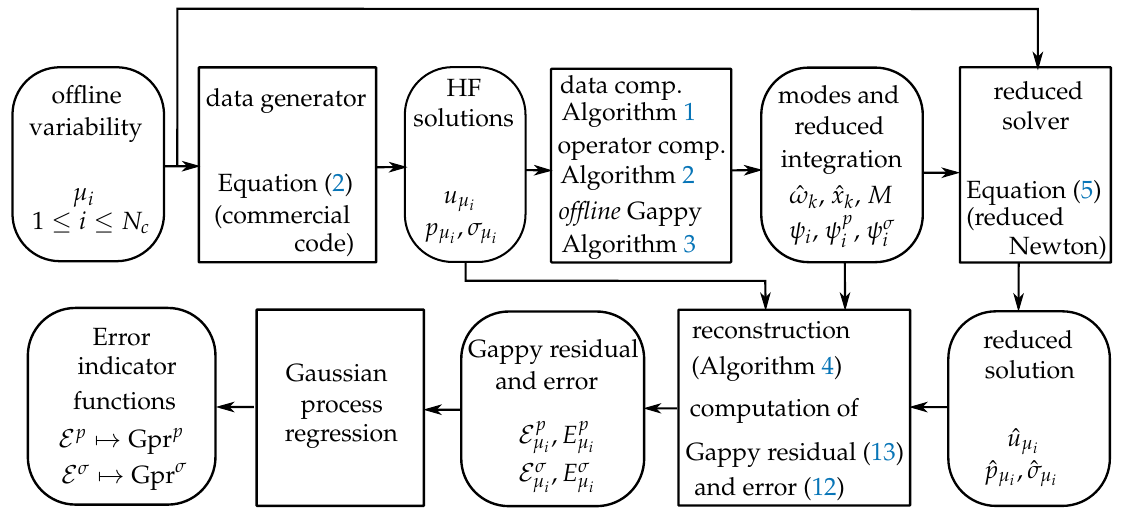
Figure 3. Workflow for the offline stage with error indicator